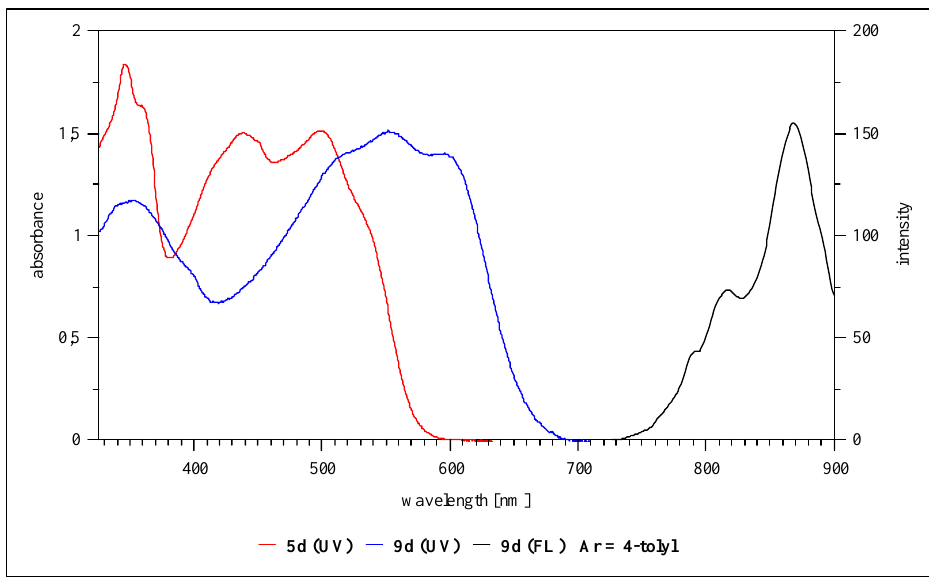
Figure 3. UV/vis- and fluorescence spectra of derivative 9d (solvent